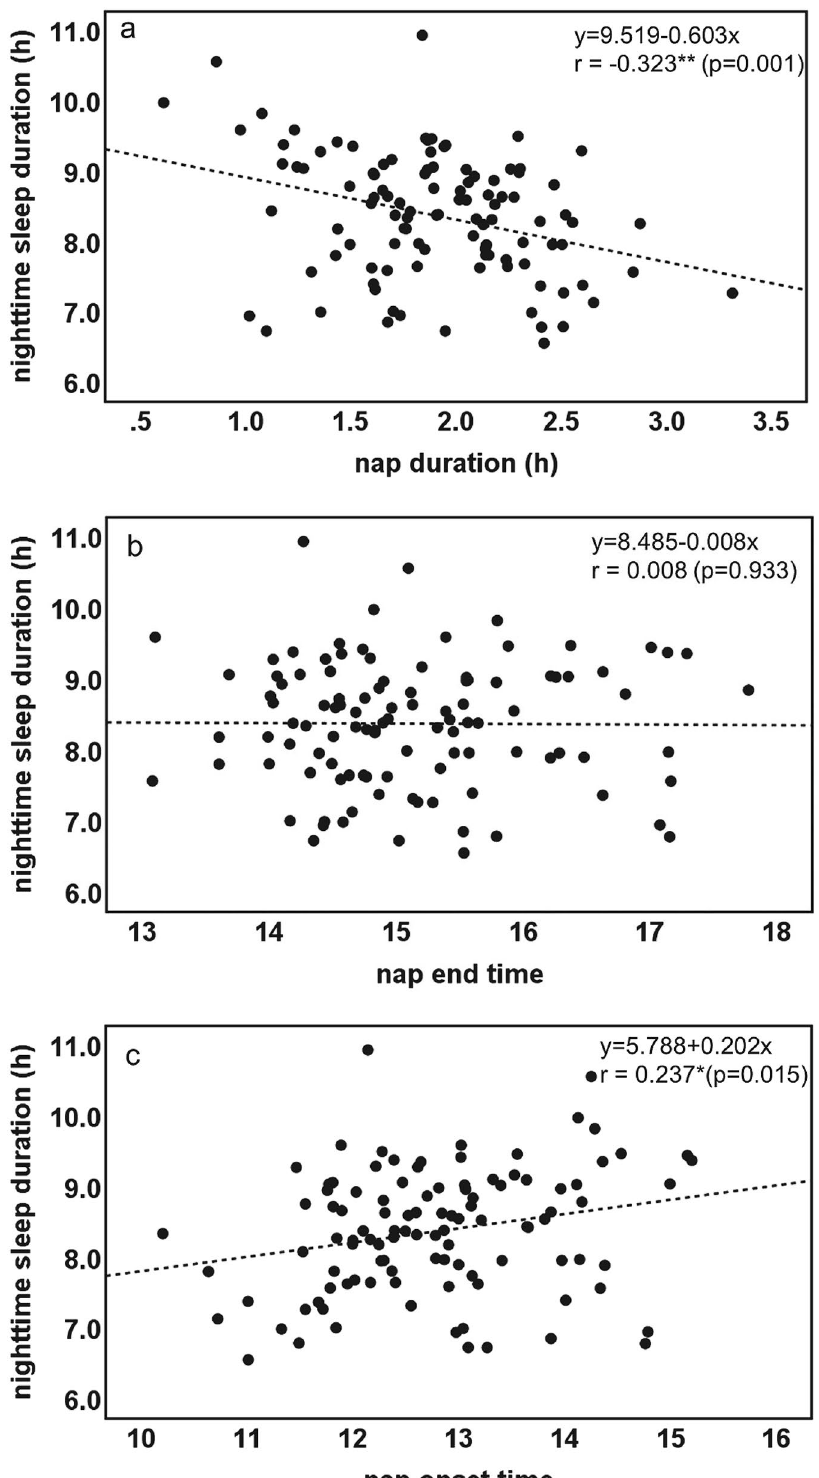
Figure 2. Correlations of nighttime sleep duration with nap duration ( a ), nap end time ( b ), and nap onset time ( c ) in term toddlers of approximately 1.5 years of age (** p < 0.01, * p <